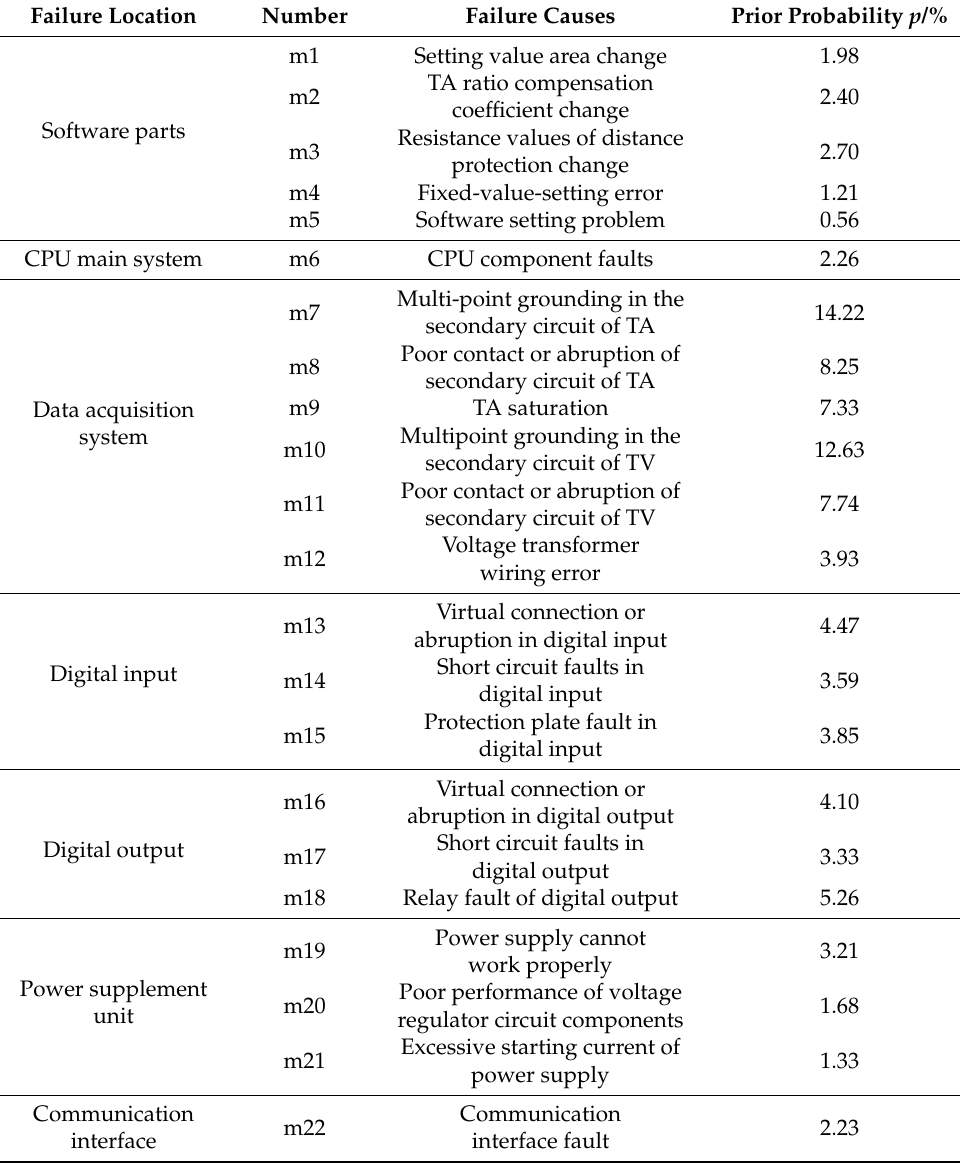
Table 1. Causes set of